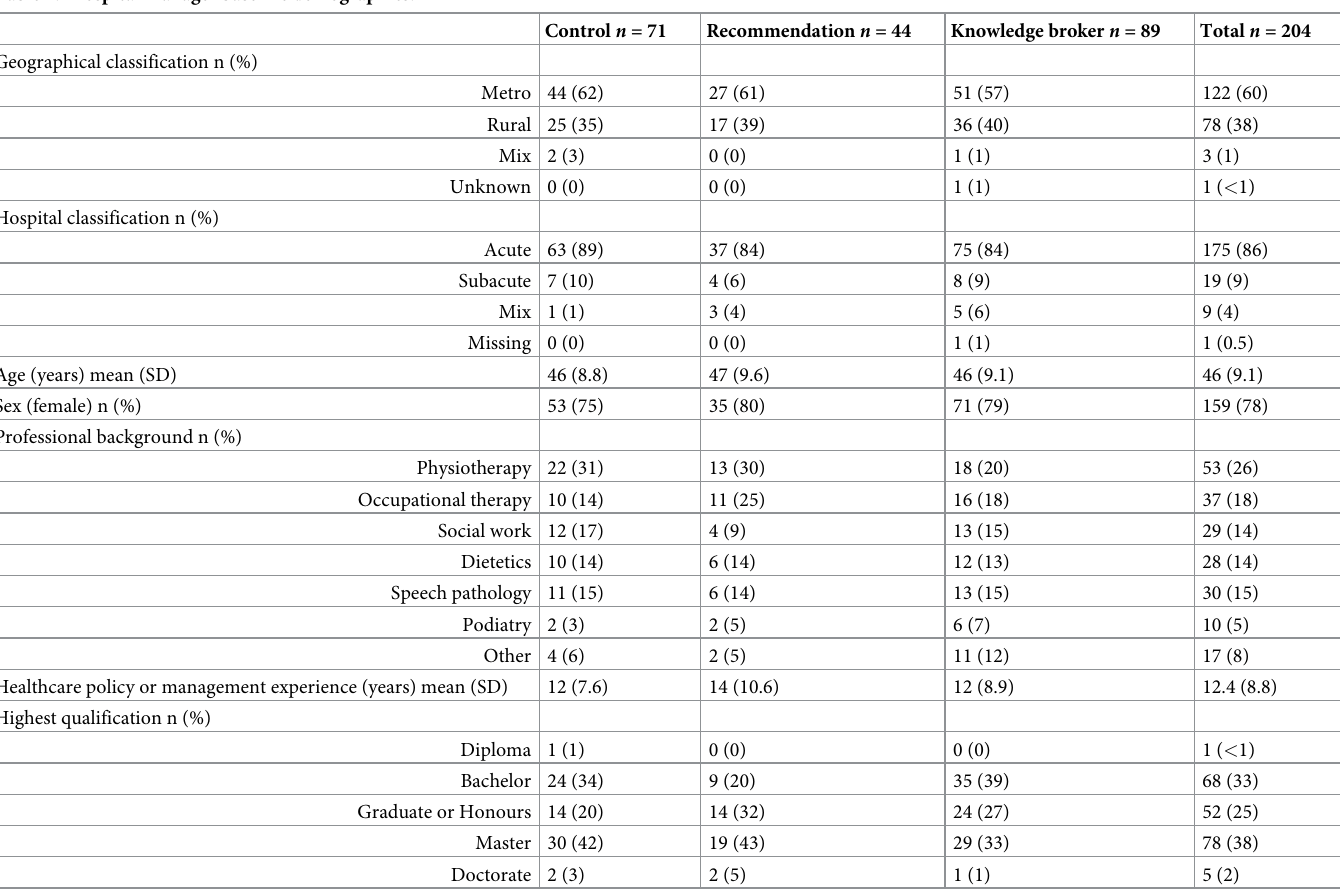
Table 2. Hospital manager baseline